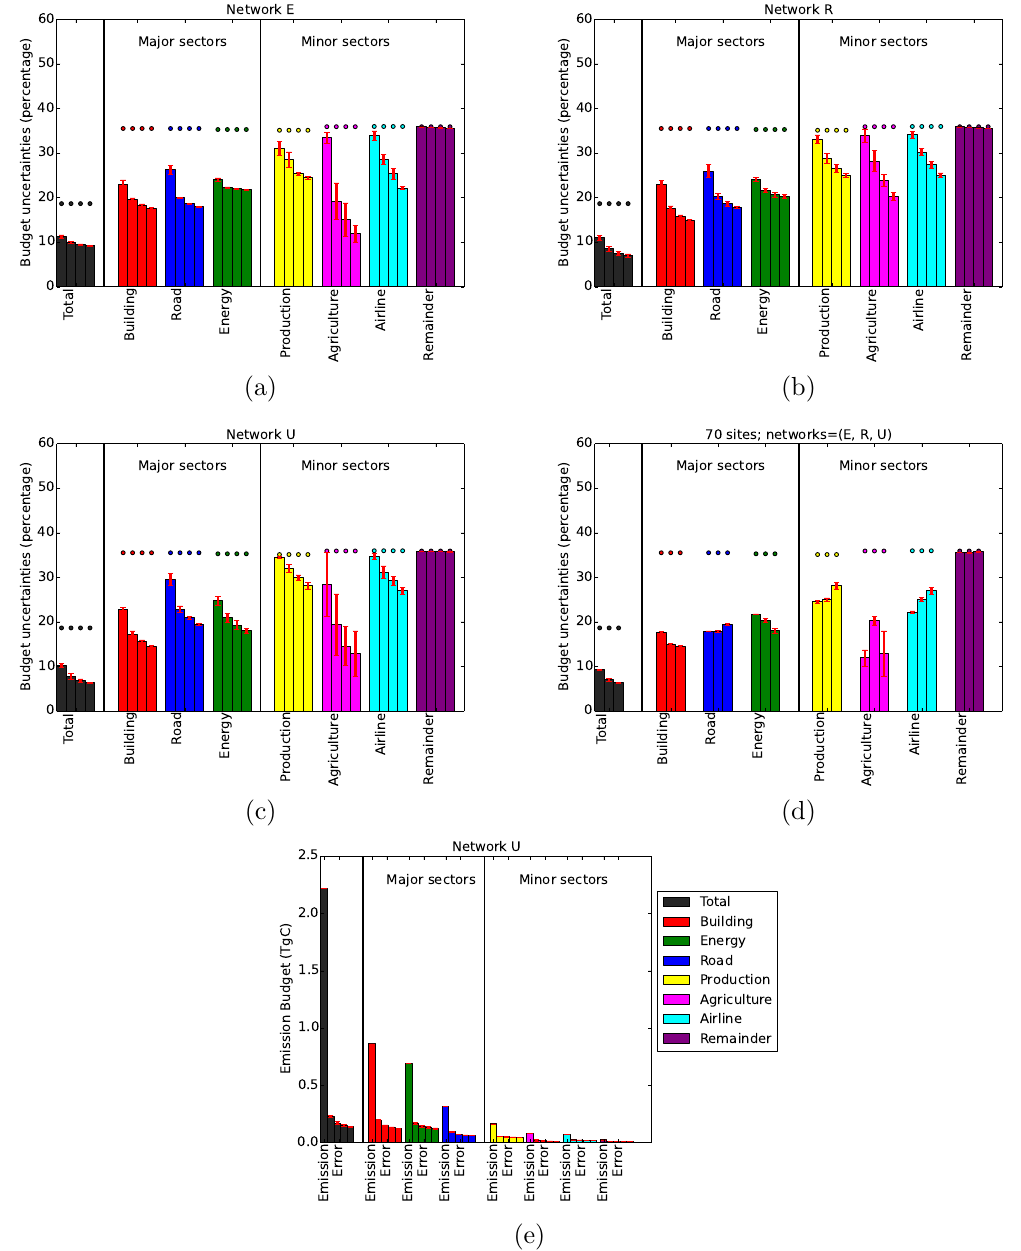
Figure 9. Budget of uncertainties in total and sectoral emission estimates by inversions using three types of networks of different sizes. Each sector has a distinct color. In (a–d) , we show the uncertainty budgets in percentage to the corresponding emission budgets computed using the IER inventory. The points indicate the percentage of prior uncertainty budgets before inversion, and the bars demonstrate the percentage of posterior uncertainty budgets after inversion. The error bars show the variations of the uncertainty budget using 10 different networks of same size (10, 30, 50, or 70) constructed as detailed in Sect. 2.3. (a–c) Reduction of uncertainties by inversions using three different types of networks of increasing sizes. For each sector, the numbers of stations corresponding to the four bars from left to right are 10, 30, 50, and 70, respectively. (d) Reduction of uncertainties by inversions using three different types of networks of 70 stations. The types of network corresponding to the three bars from left to right are E, R, and U, respectively. (e) Comparison between the inventory budgets and uncertainty budgets (both in TgC) using the uniform network of increasing sizes. For each sector, the leftmost bar shows the inventory budget, and the four remaining bars to the right show the budget of uncertainties in posterior emission estimates by inversions using 10, 30, 50, and 70 stations,